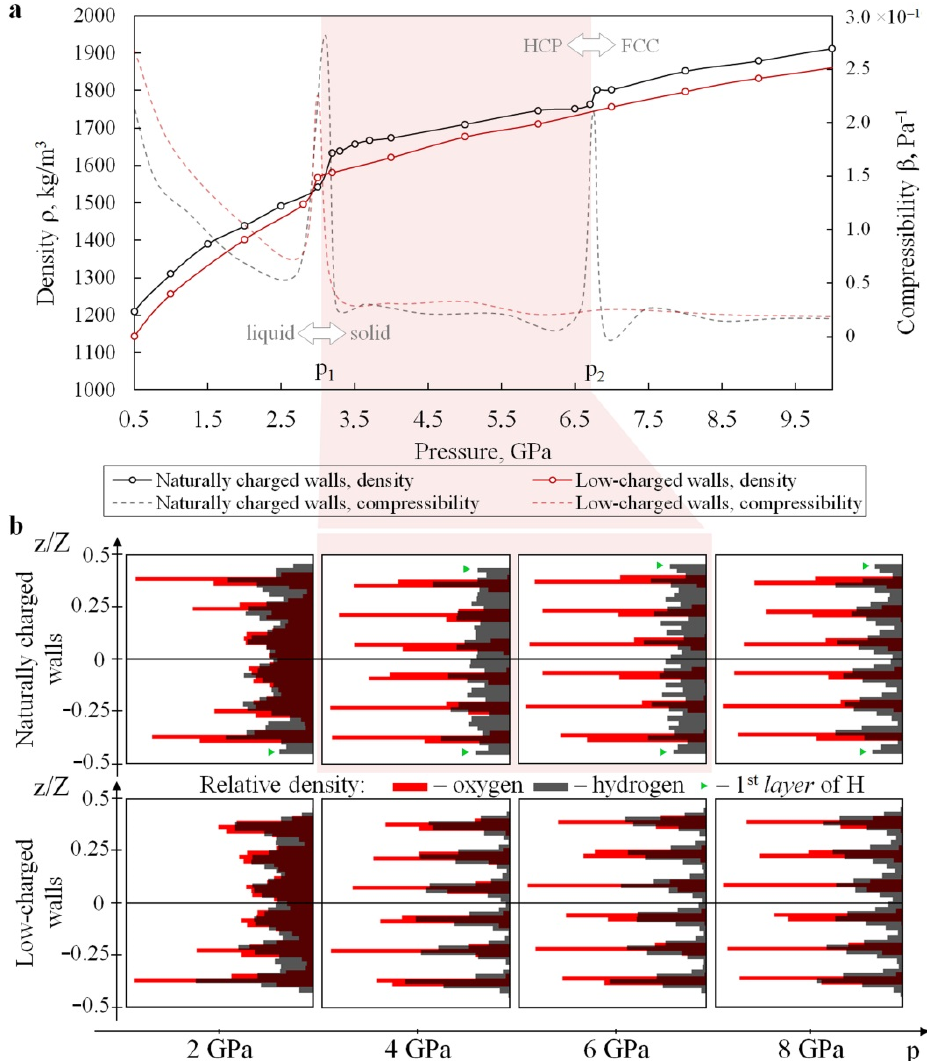
Figure 2. Properties and phases of nanoconfined water depending on applied pressure and wall surface polarity. Results were obtained for the base models of 36[2Me (II) (OH) 2 · 7H 2 O]: ( a ) Numerically obtained density–pressure diagram for confined water in both studied systems in the pressure range 0.5–10 GPa. The shaded region indicates the crystalline phase with an HCP-like structure of water in the naturally charged host model; the region on the left corresponds to the liquid phase of confined water; the region on the right corresponds to ice with the high-density FCC-like structure (also in the naturally charged host model). ( b ) One-dimensional (along z) density profiles of water oxygen (red bars) and hydrogen (grey bars) atoms in the naturally charged ( top ) and low-charged ( bottom ) minerals at different pressures. The presence of six water layers is evident. The first layers of hydrogen atoms in the proximity of the hydrophilic walls are indicated by small green triangular markers. In the case of hydrophobic walls, the position of the first layer of H coincides with the first layer of O.